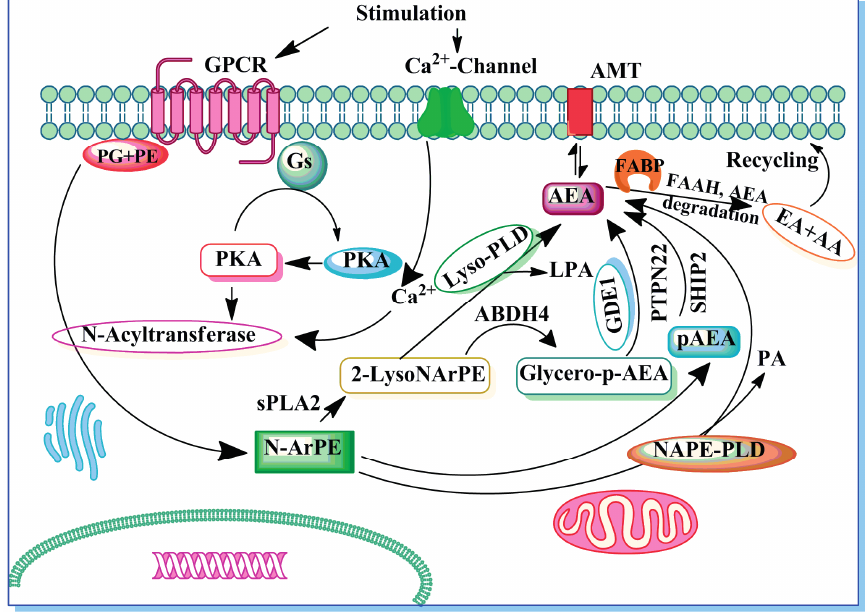
Figure 1. The potential enzymes involved in anandamide (AEA) biosynthesis. Stimulation of G-protein coupled receptor (GPCR) mediated adenylate cyclase and cAMP-dependent protein kinase (protein kinase A, PKA) potentiate N -acyltransferase (Ca 2+ -dependent transacylase) (NAT). A fatty arachidonic acid chain is transferred by NAT from the sn-1 position of phospholipids (phosphoglycerides, PG) to the primary amine of phosphatidylethanolamine (PE) in a Ca 2+ -dependent manner, forming an N -arachidonyl phosphatidylethanolamine (N-ArPE). This N-ArPE intermediate is then hydrolyzed by a phospholipase D (PLD)-like enzyme to generate AEA. In addition, potential alternative pathways for AEA formation from N-ArPE through 2-lysoNArPE and pAEA catalysed by sPLA2, lyso-PLD, ABDH4, GDE1 or PTPN22 and SHIP2 are shown (see text for